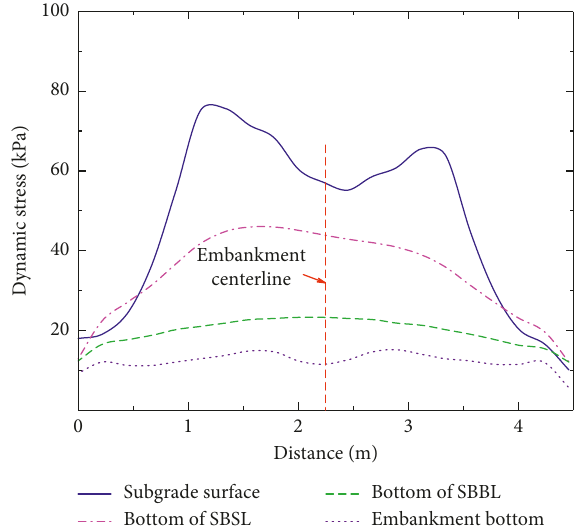
Figure 17: Transverse distributions of dynamic stresses at different